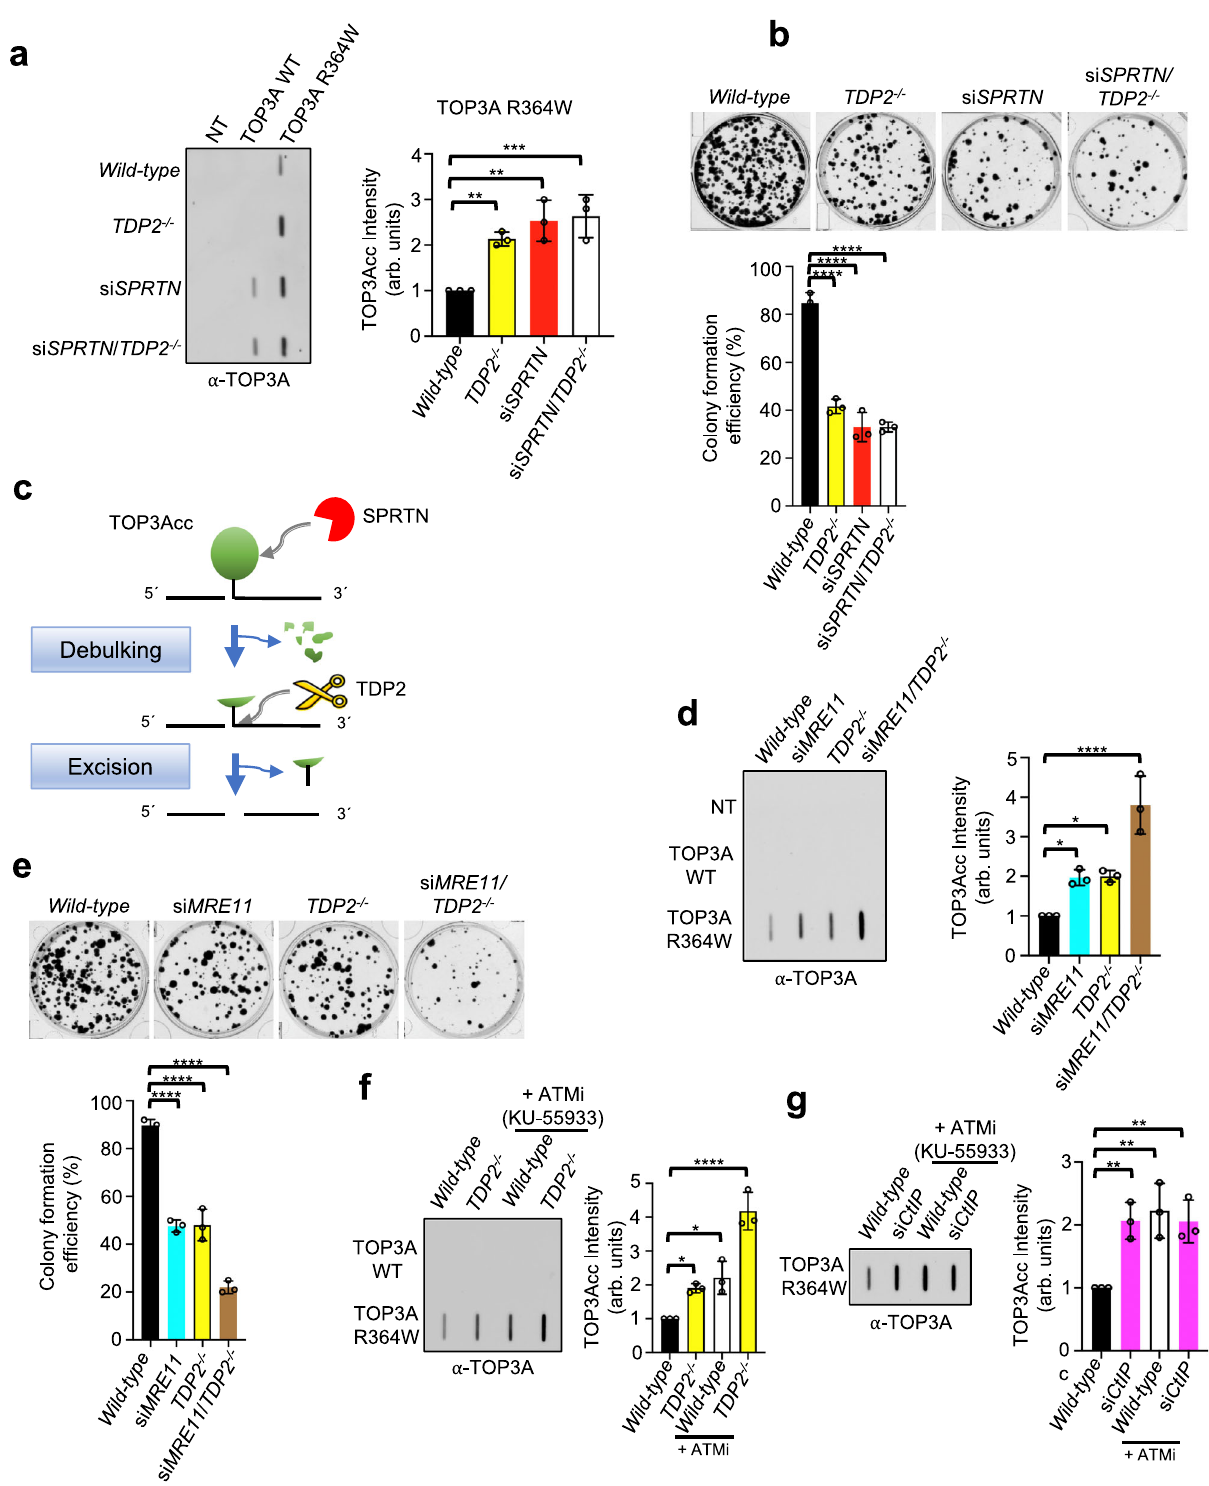
TOP3Accs (Fig. 6f and Supplementary Fig. 8b). Conversely, ATM inhibition in MRE11-depleted cells caused no further increase in TOP3Accs level in comparison with ATM inhibited and MRE11- de fi cient cells alone (Supplementary Fig. 8c), indicating an epistasis of ATM inhibition and MRE11 depletion for the repair of